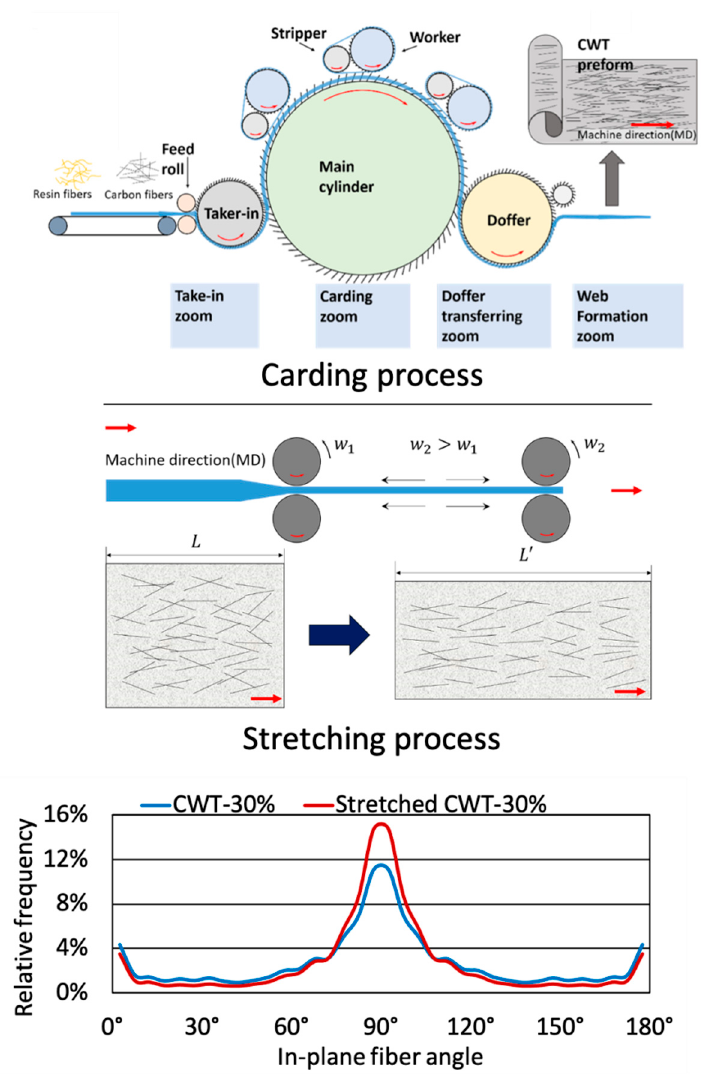
Figure 14. Carding process, stretching process, and the in-plane fiber orientation distribution of CWT with/without stretching.